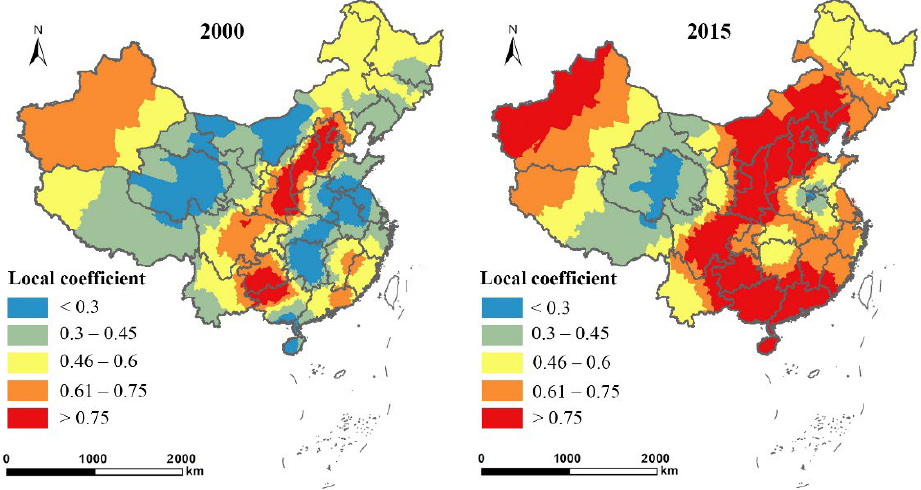
Figure 7. Spatial distribution of the local coefficients of road density (ln RD ) in 2000 and 2015.